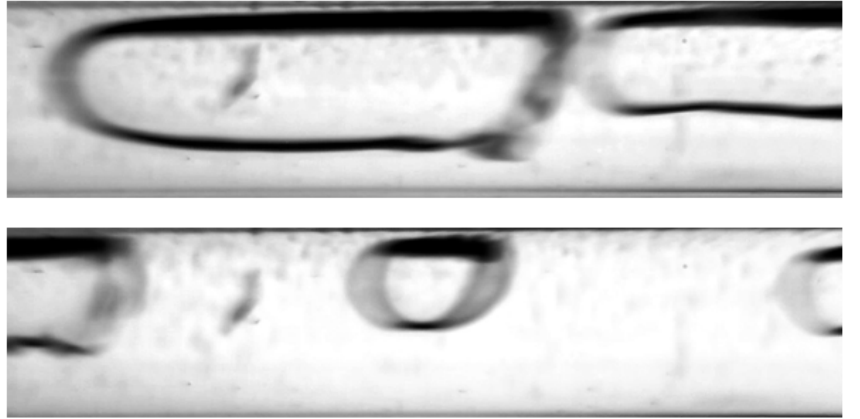
Figure 15. Example of the coexistence of a slug and bubble substructure during condensation of the HFE7000 refrigerant in a minichannel with an internal diameter of d h = 2.0 mm ( G = 602 kg/m 2 s; x = 0.003; ϕ = 0.36; t s = 32 °C).